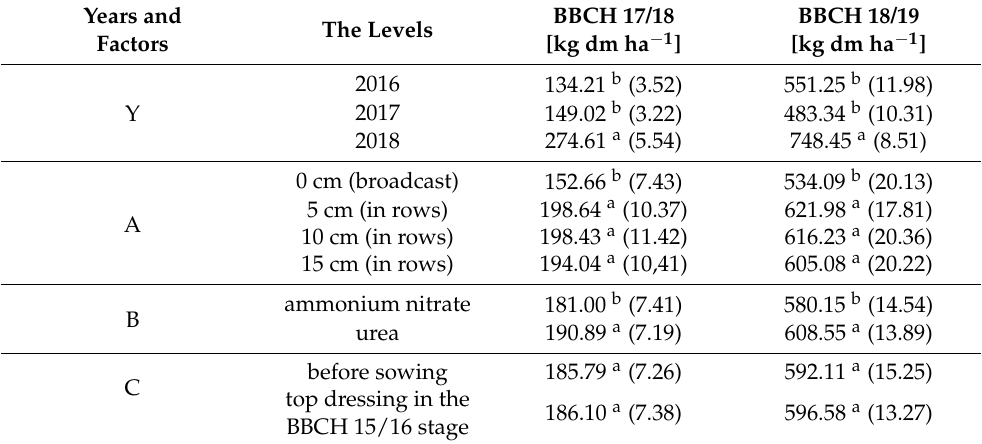
Table 4. Mean values of the traits for the years (Y), NP fertilizer sowing depth (A), type of